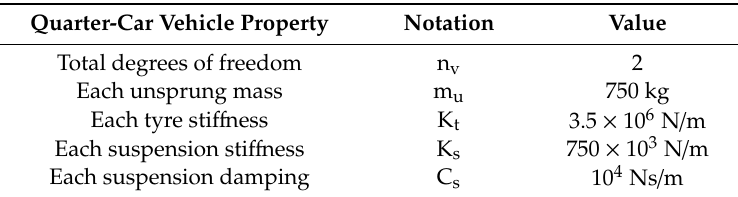
Table 2. Properties of the quarter-car.